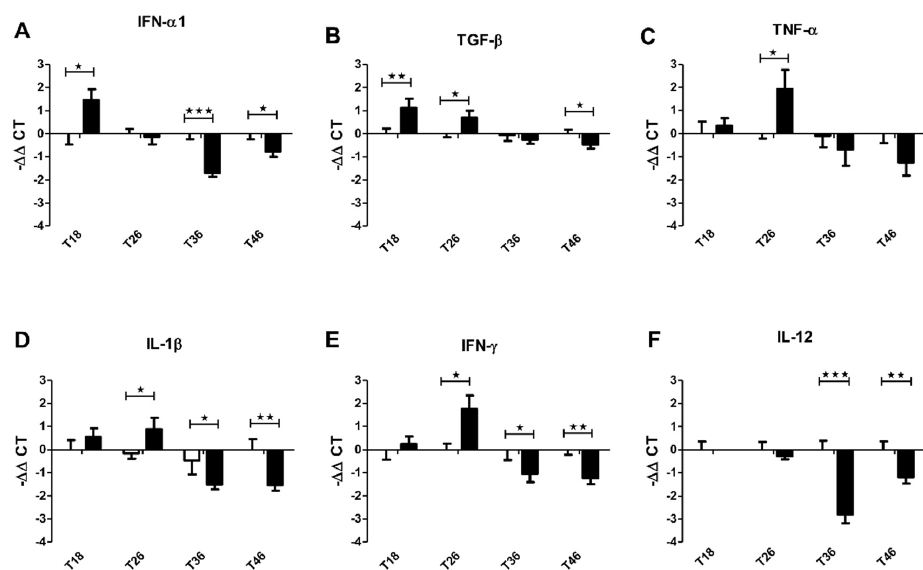
Figure 3. Kinetics of the immunomodulation effect of filifolinone on Atlantic salmon. The figure shows the changes in the expression of pro and anti-inflammatory cytokines at 2, 10, 20, and 30 days post-intramuscular injection of 100 µ g filifolinone (T18, 26, 36, and 46 days of experimentation, respectively). The expressions of ( A ) IFN- α 1; ( B ) TGF- β ( C ) TNF- α ; ( D ) IL-1 β ; ( E ) IFN- γ ; and ( F ) IL-12 were evaluated using head kidney tissue of fish treated with filifolinone (black bars) and untreated fish (white bars). The expression of immune genes was normalized with respect to the expression of elongation factor 1 α (ef1a) and the mean value under the control condition.